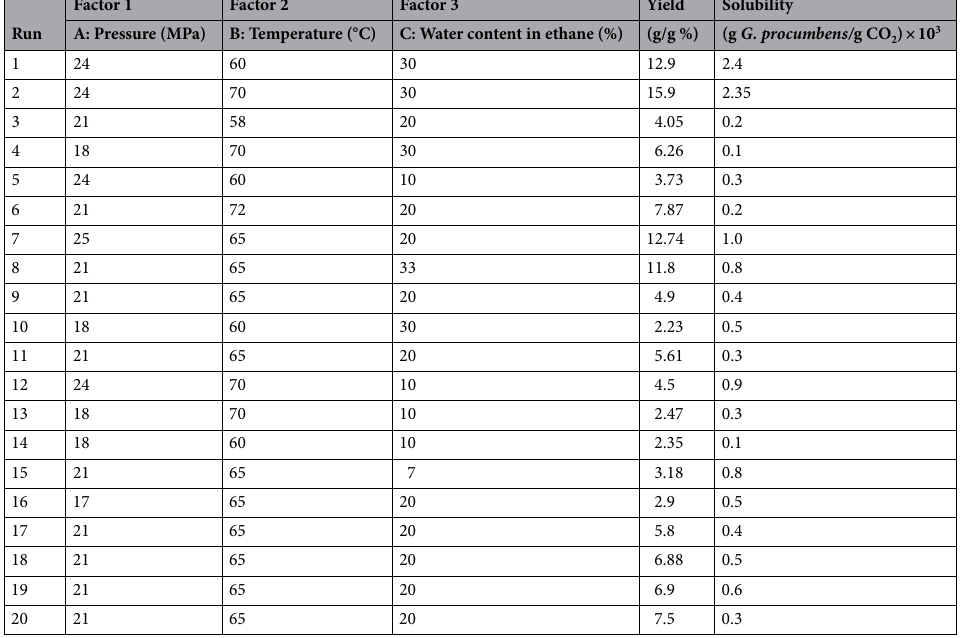
Table 7. The results obtained from the CCD design of the experiments.